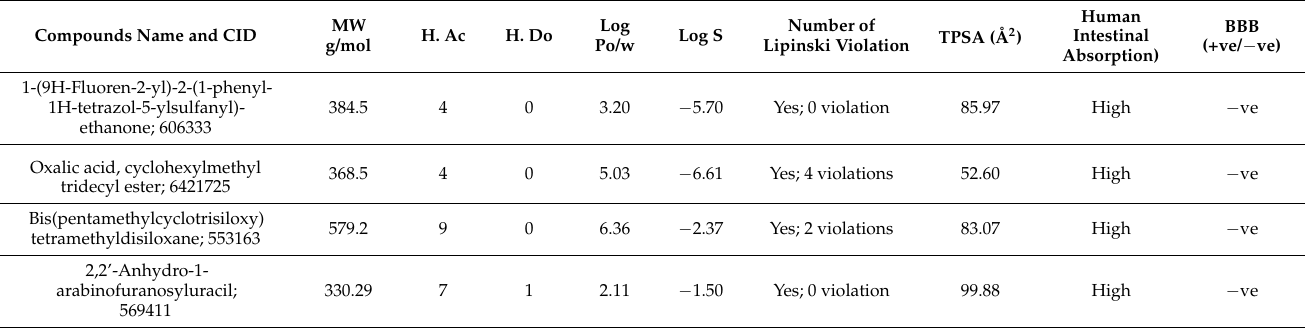
Table 3. Pharmacological assessment of the screened hit ligand